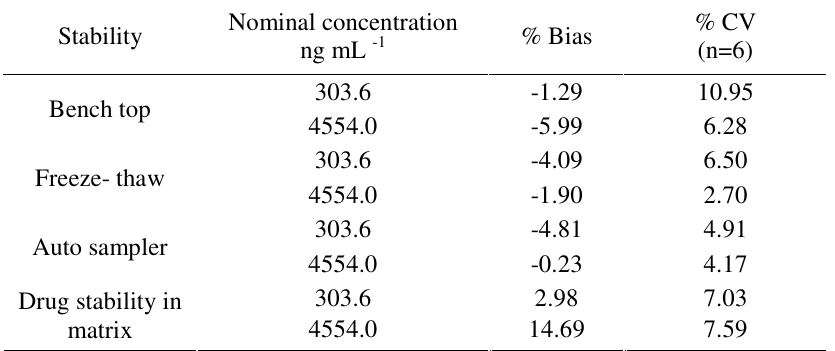
Table 5. Stability Data